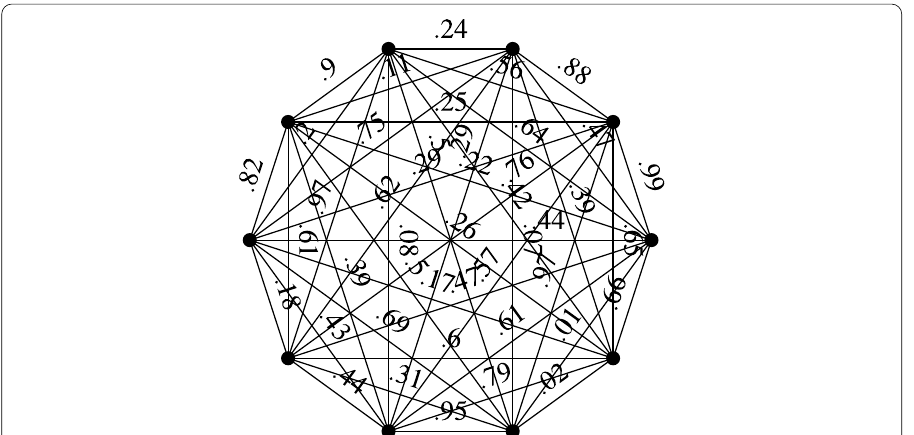
Fig. 2 Probabilistic instance of a complete graph K 10 with uniformly distributed edge